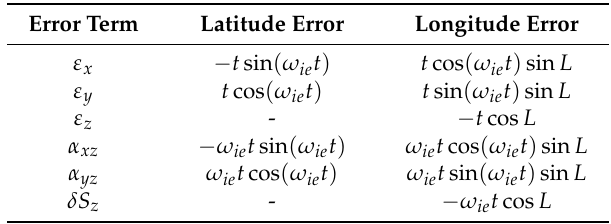
Table 1. Position errors caused by comagnetometer